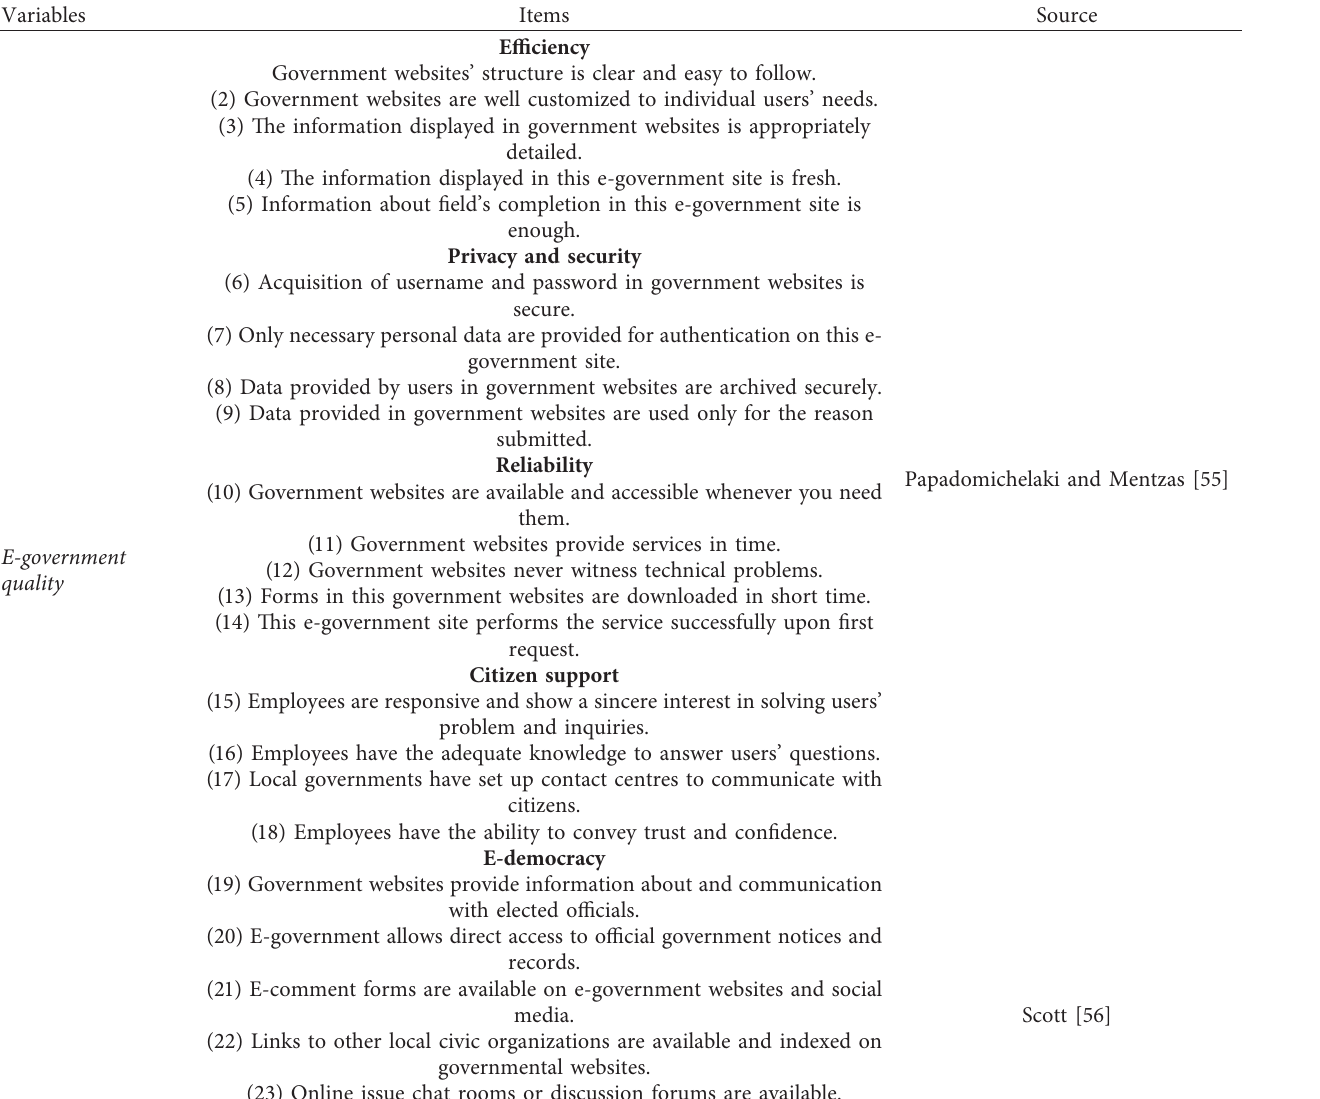
Table 1: Research